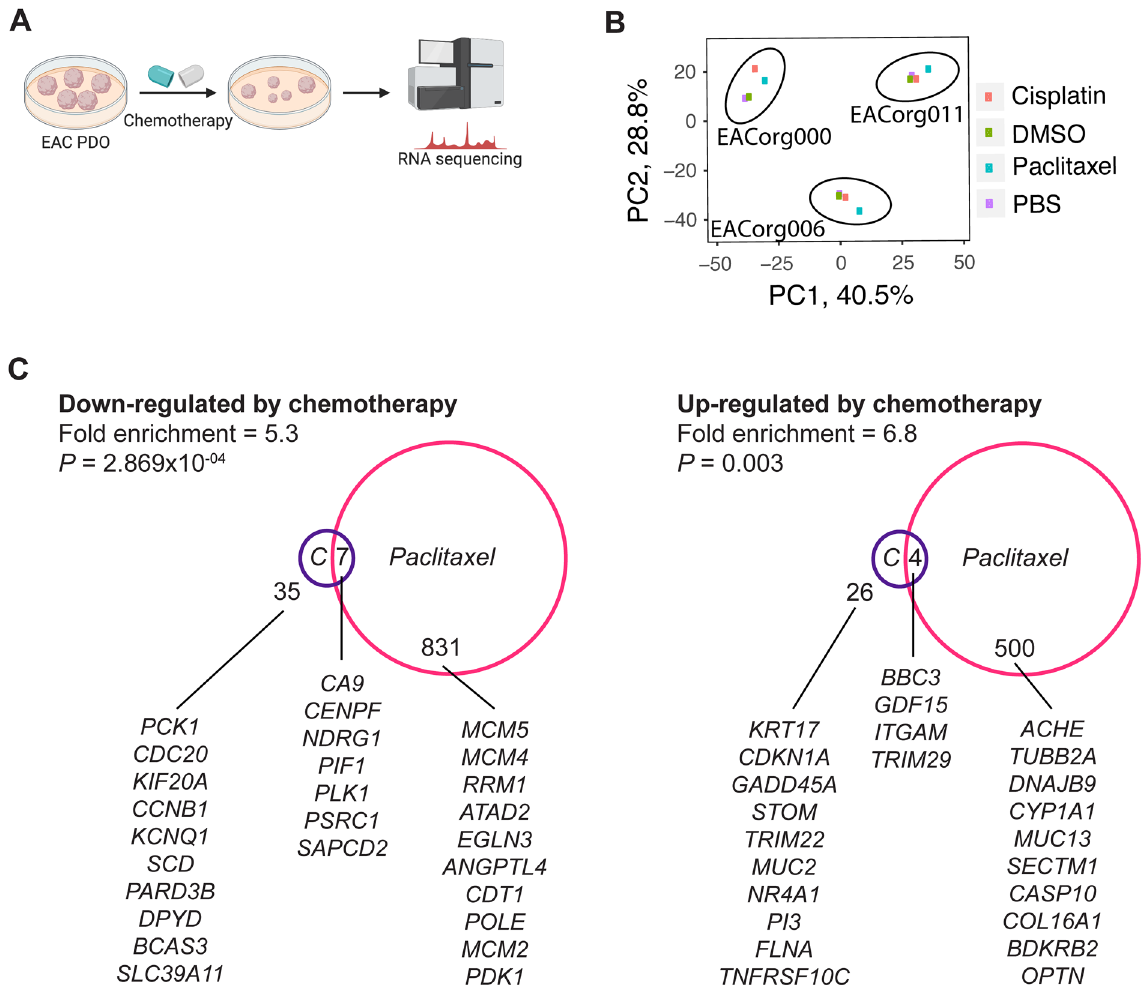
Figure 4. EAC PDOs can be used to identify drivers of therapeutic response. ( A ) Schematic of the RNAseq setup. Created with BioRender.com. ( B ) Principle component analysis (PCA) of differentially expressed genes with P < 0.02. ( C ) Venn diagrams of DEGs ( P < 0.02) induced by cisplatin or paclitaxel treatments, and the 10 most significantly altered genes are listed. Significance of overlap and fold enrichment as determined by hypergeometric